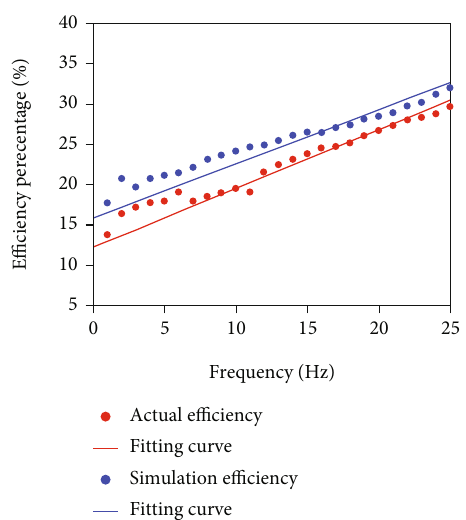
Figure 12: E ffi ciency of capsule robot at di ff erent frequencies.